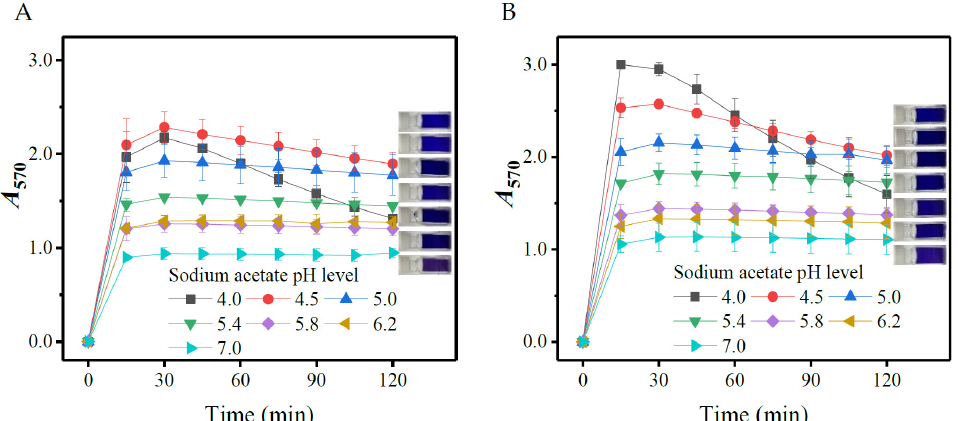
Figure 6. Effects of sodium acetate concentration on the color yield of gamma-aminobutyric acid ( A ) and L-glutamic acid ( B ). The rightmost part of each diagram shows the reacted mixtures supple- mented with 35 μ L of variable concentrations (from top to bottom: 1.0, 0.8, 0.6, 0.4, 0.2, and 0 M) of sodium acetate (pH 5.0). A 570 : absorbance at 570 nm.